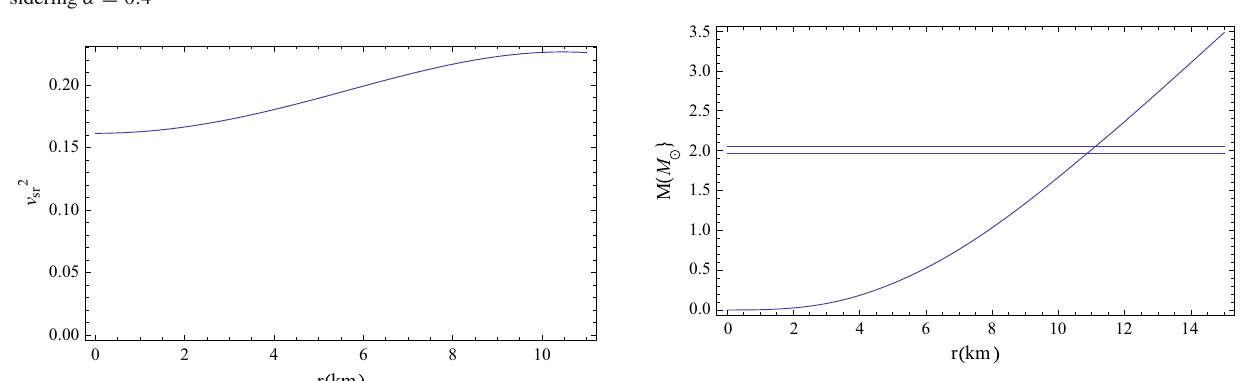
Fig. 9 Variation of v 2 sr with r of PSR J0348+0432